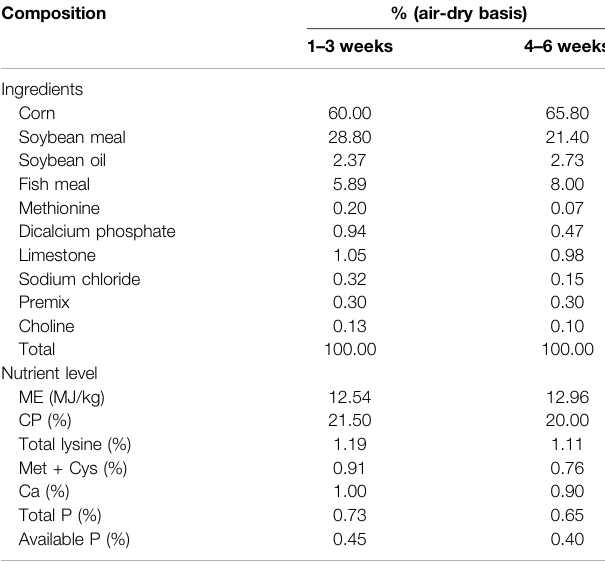
TABLE 2 | Composition and nutrient level of basal